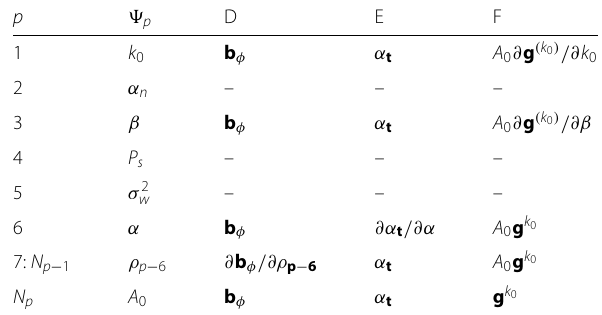
Table 3 Definition of elements in (48) required for additional derivatives in (34) when computing the